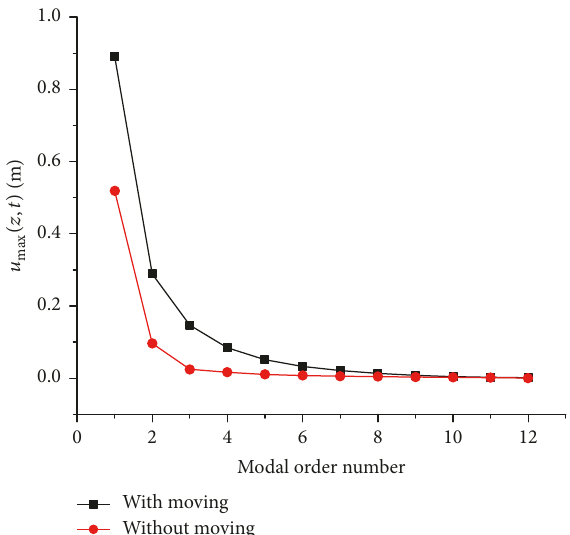
Figure 8: Comparison of modal dynamic responses between the cases with top-end tube moving and without top-end tube moving.